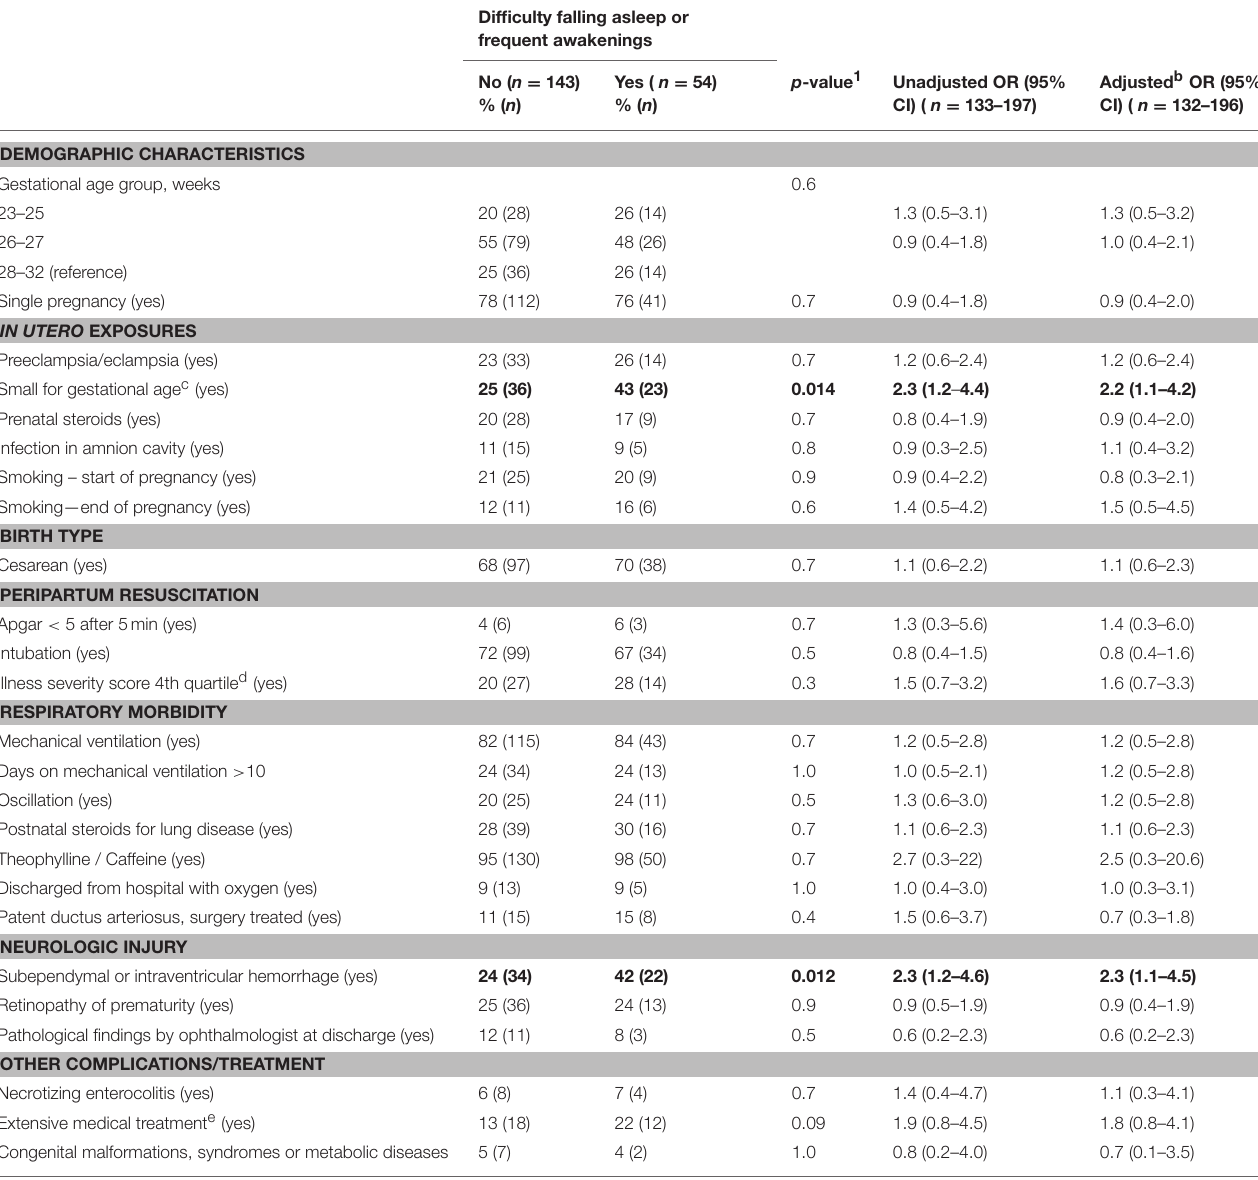
TABLE 3 | Prenatal and neonatal factors predicting difficulty falling asleep or frequent awakenings at 11 years of age among children born extremely preterm a . Difficulty falling asleep or frequent